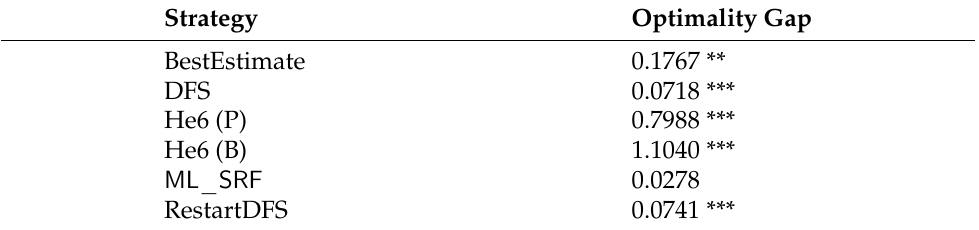
Table 7. Set cover: ML model with on_both = Second, on_leaf = RestartDFS and prune_on_both = False against baselines, with equal time limits for each problem. Pairwise t -tests against the ML policy: ‘***’ p < 0.001, ‘**’ p <